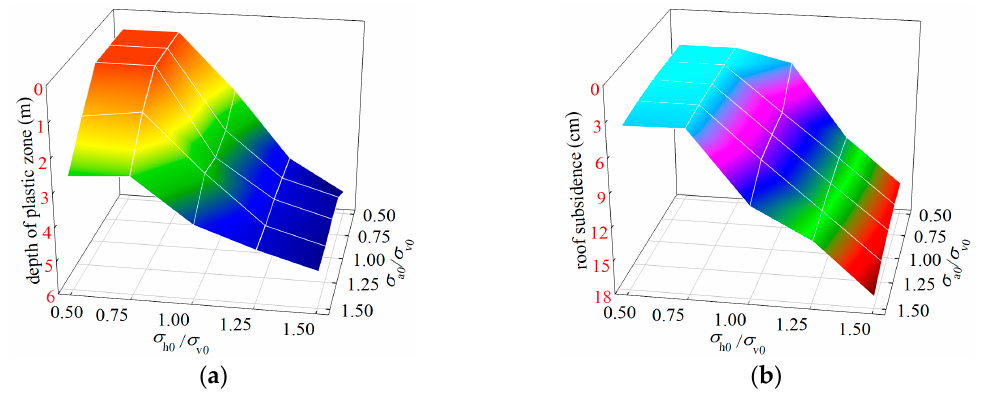
Figure 9. Results considering only strain softening: ( a ) roof plastic zone depth and ( b ) roof subsidence. Energies 2020 , 13 , x FOR PEER REVIEW